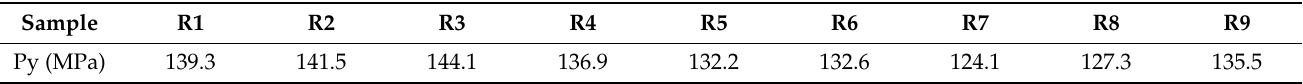
Table 3. The Py values of R1–R9